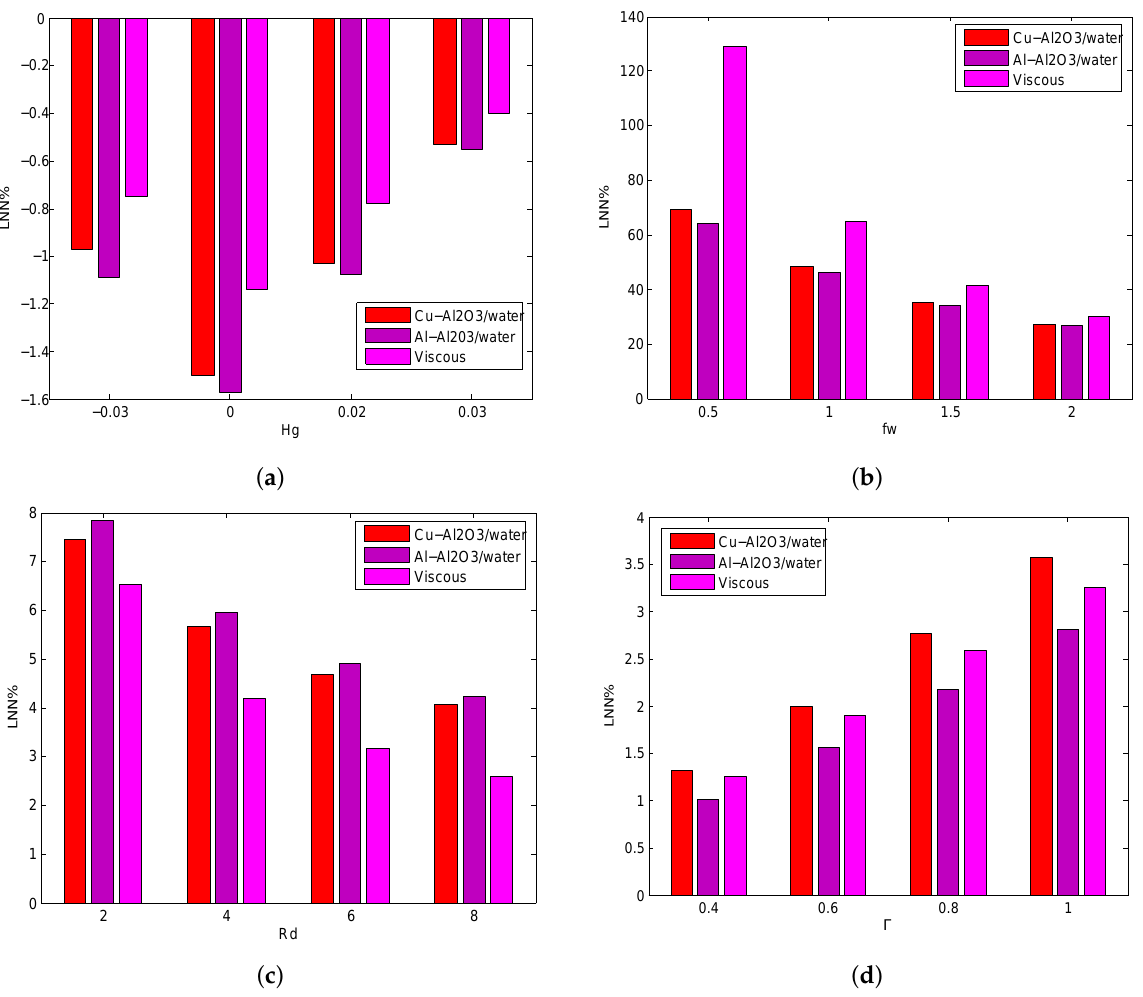
Figure 7. Thedeclining/developing percentage of LNN for various values of Hg ( a ), fw ( b ), Rd ( c ), Γ ( d ) for both